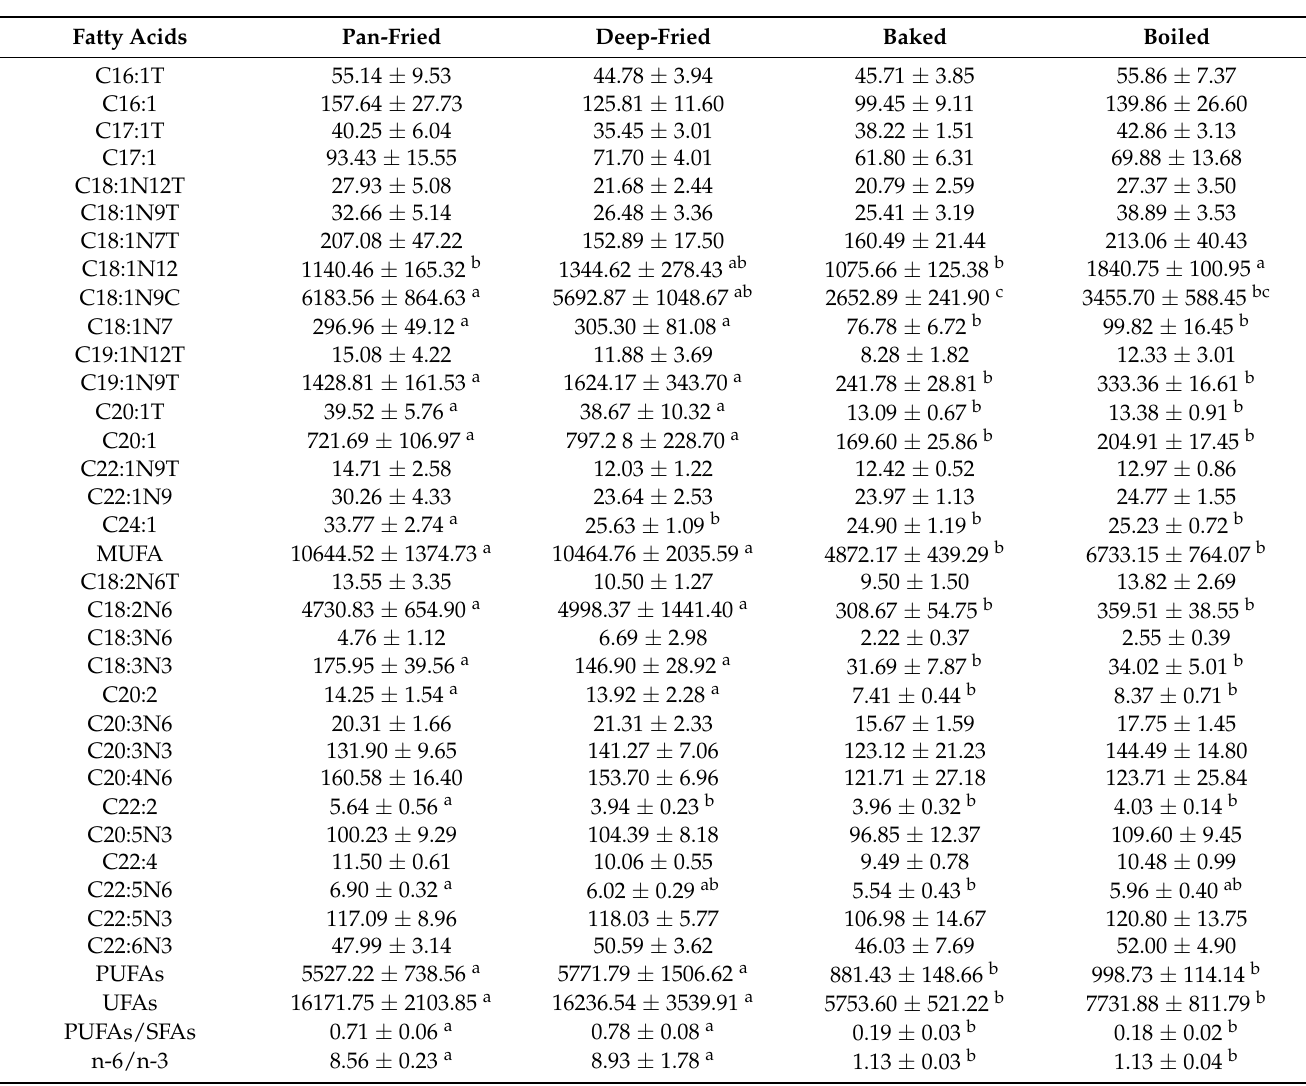
Figure 5 is a top-view projection of the three-dimensional spectrum shown in Figure 4 on a two-dimensional plane. The whole spectrum represents all the VFCs in the three kinds of heat-treated meat samples. The red vertical line at abscissa 1.0 in Figure 5a is the